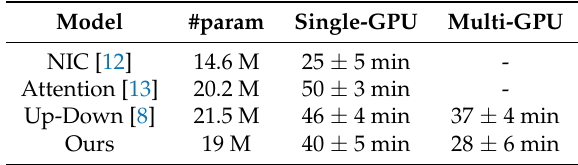
Table 2. Comparison of the number of parameters and the training speeds per epoch of different image captioning models. The work in [12,13] presents our implementation based on the paper using PyTorch, whereas the work in [8] is the open-source implementation using